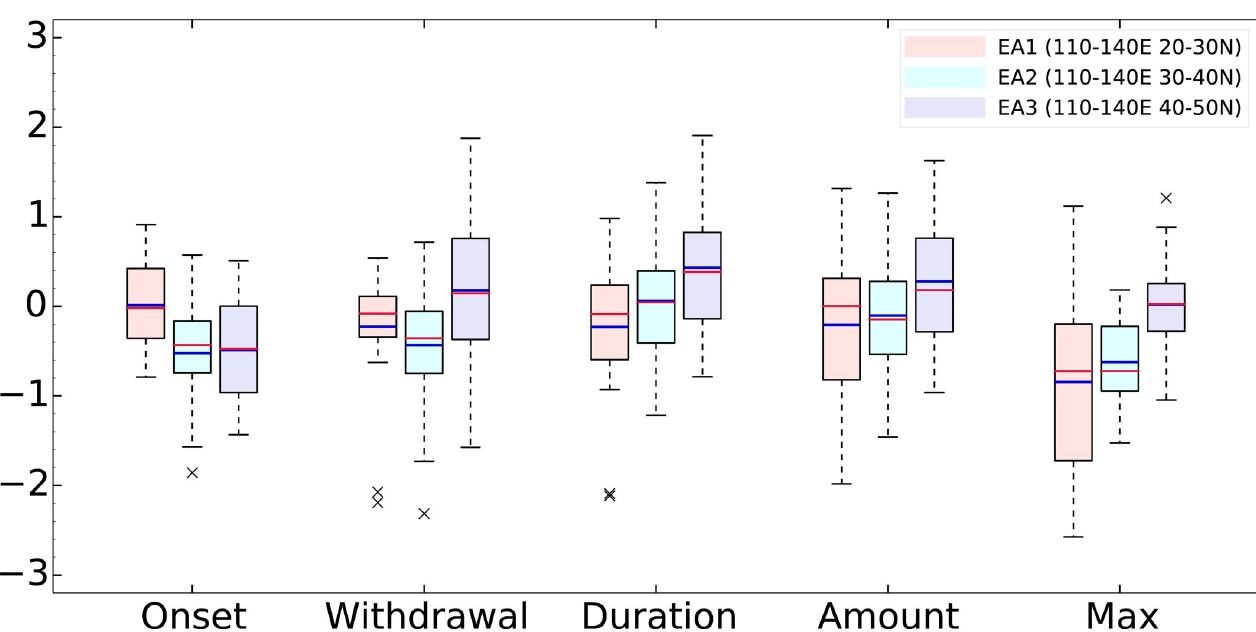
Fig 3. Normalized 30 CMIP6 model biases relative to observations for the EASM characteristics in Table 1. Analysis sub-regions are EA1 (20–30˚N), EA2 (30–40˚N), and EA3 (40–50˚N). Biases are normalized by the observation of each variable. Blue and red bars indicate mean and median values, respectively.